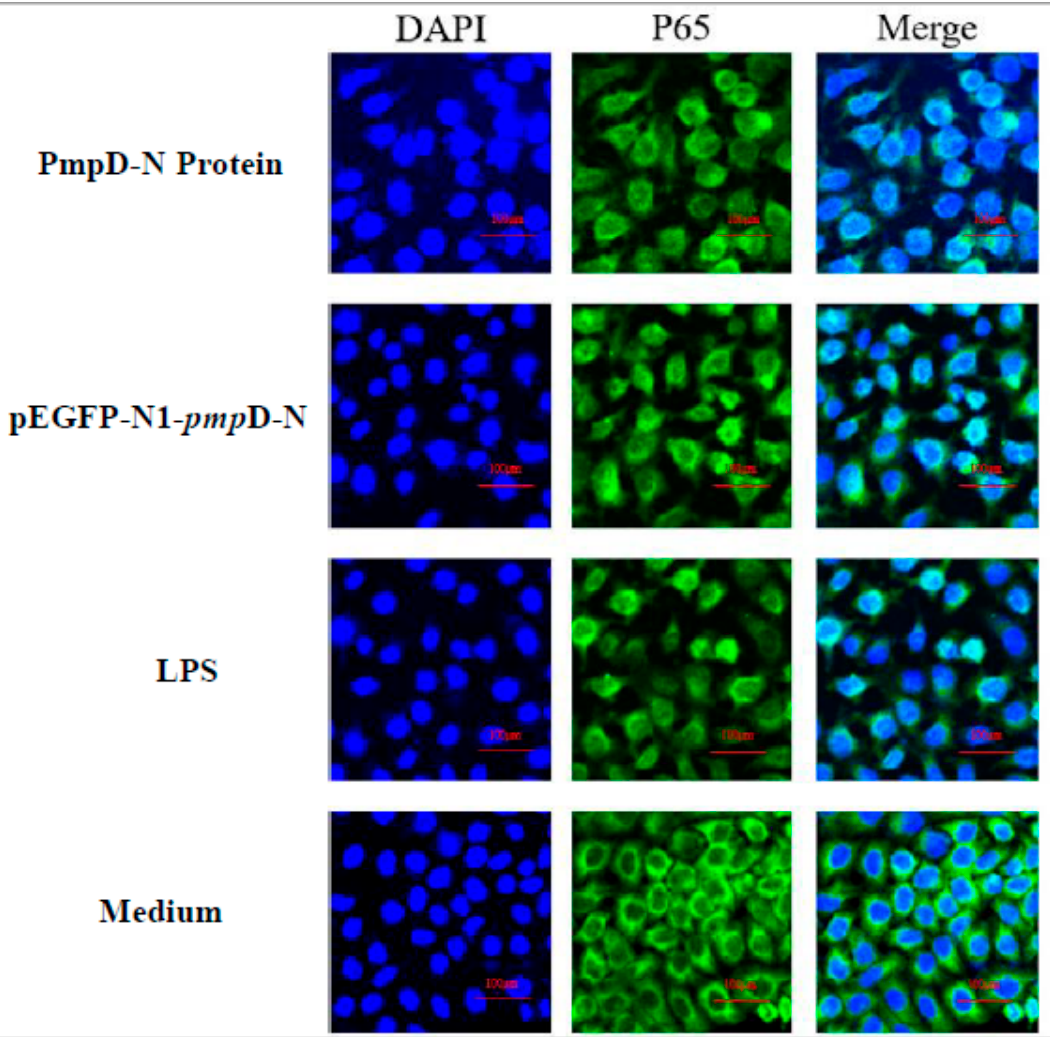
Figure 5. Detecting NF- κ B p65 migration by confocal microscopy. NF- κ B p65 nuclear migration in Figure 5. Detection of NF- κ B p65 migration by confocal microscopy. NF- κ B p65 nuclear migration HD11 cells was detected by immunofluorescence microscopy. The p65 molecules migrated from the in HD11 cells was detected by immunofluorescence microscopy. The p65 unit was stained with Alexa Fluor ® 488 (green) and nuclei were visualized by DAPI counterstain (blue). Note the di ff use cytoplasm to the nucleus post-treatment with the recombinant PmpD-N, pEGFP-N1-pmpD-N, or distribution of NF- κ B p65 (green) in the plasmid control group.